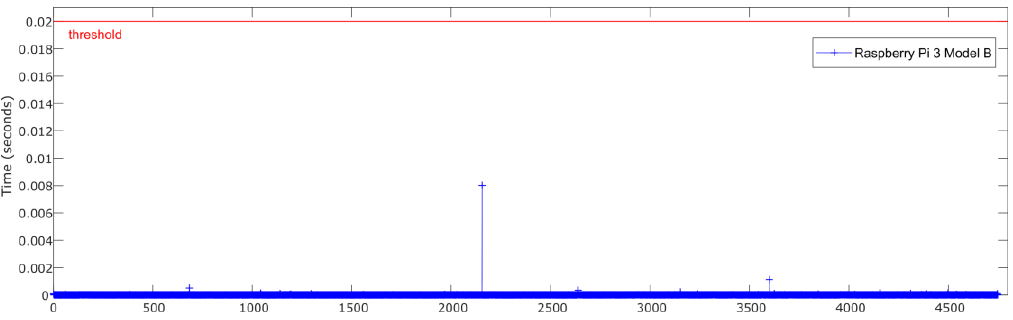
Figure 11. Test 2. Processing time of each iteration for Raspberry Pi 3 Model B.